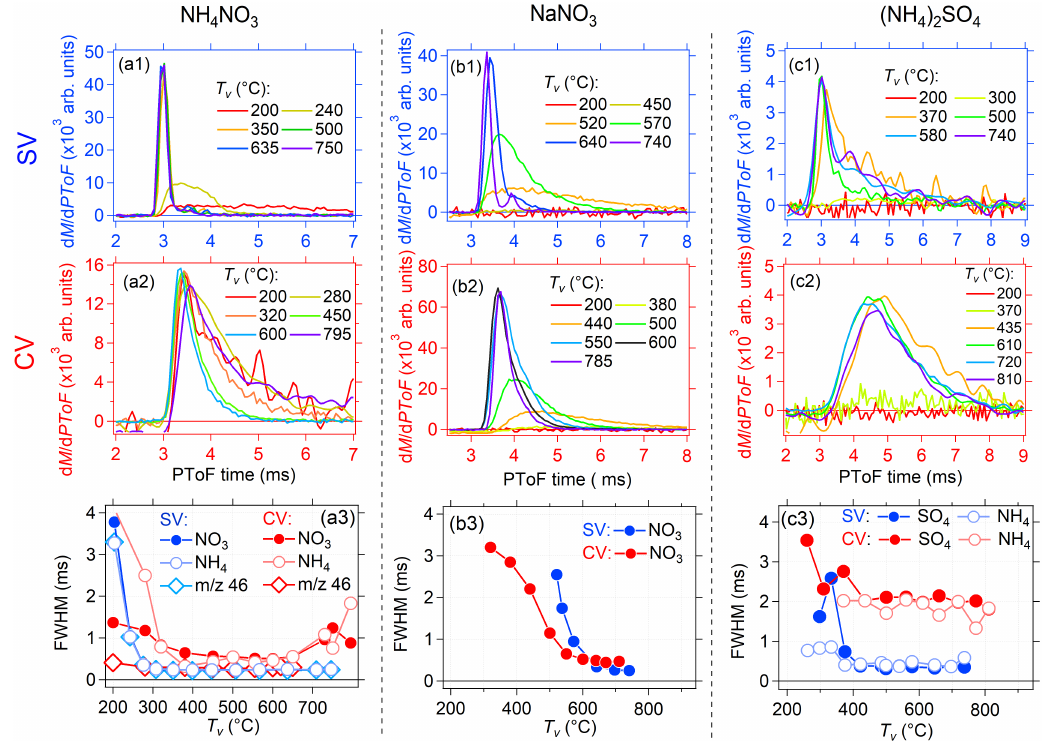
Figure 13. Size-resolved detection of (a) 250nm (NH 4 ) 2 SO 4 , (b) 300nm NH 4 NO 3 and (c) 300nm NaNO 3 using the PToF acquisition mode from the SV and CV as a function of T v . Particle peak widths of (a3) NH 4 NO 3 , (b3) NaNO 3 and (c3) (NH 4 ) 2 SO 4 as a function of T v are also shown.